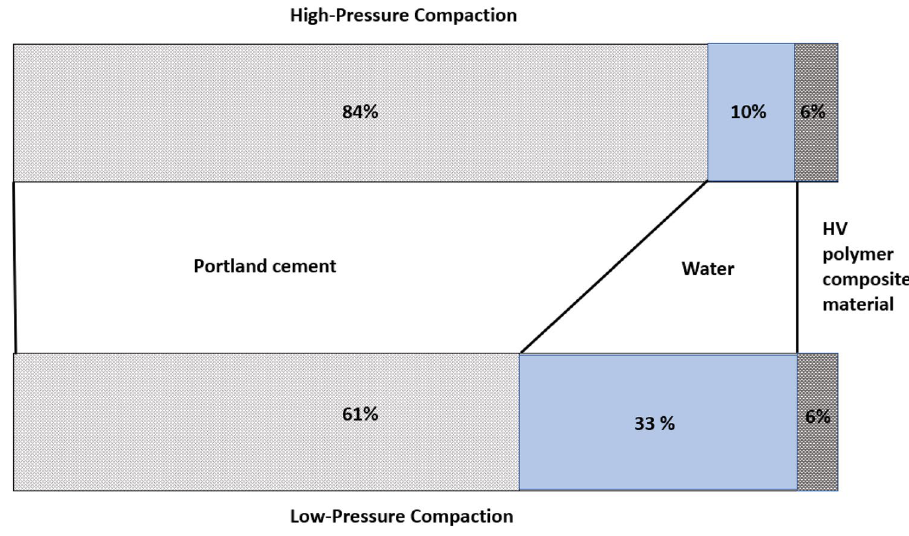
Fig. 4 a High voltage hybrid FCP admixtures that were processed into chips (middle) and a powder (~ 52.85 µm) (far right), and then b mixed with Portland cement and water and high-pressure compacted into a solid rectangular brick- shaped material